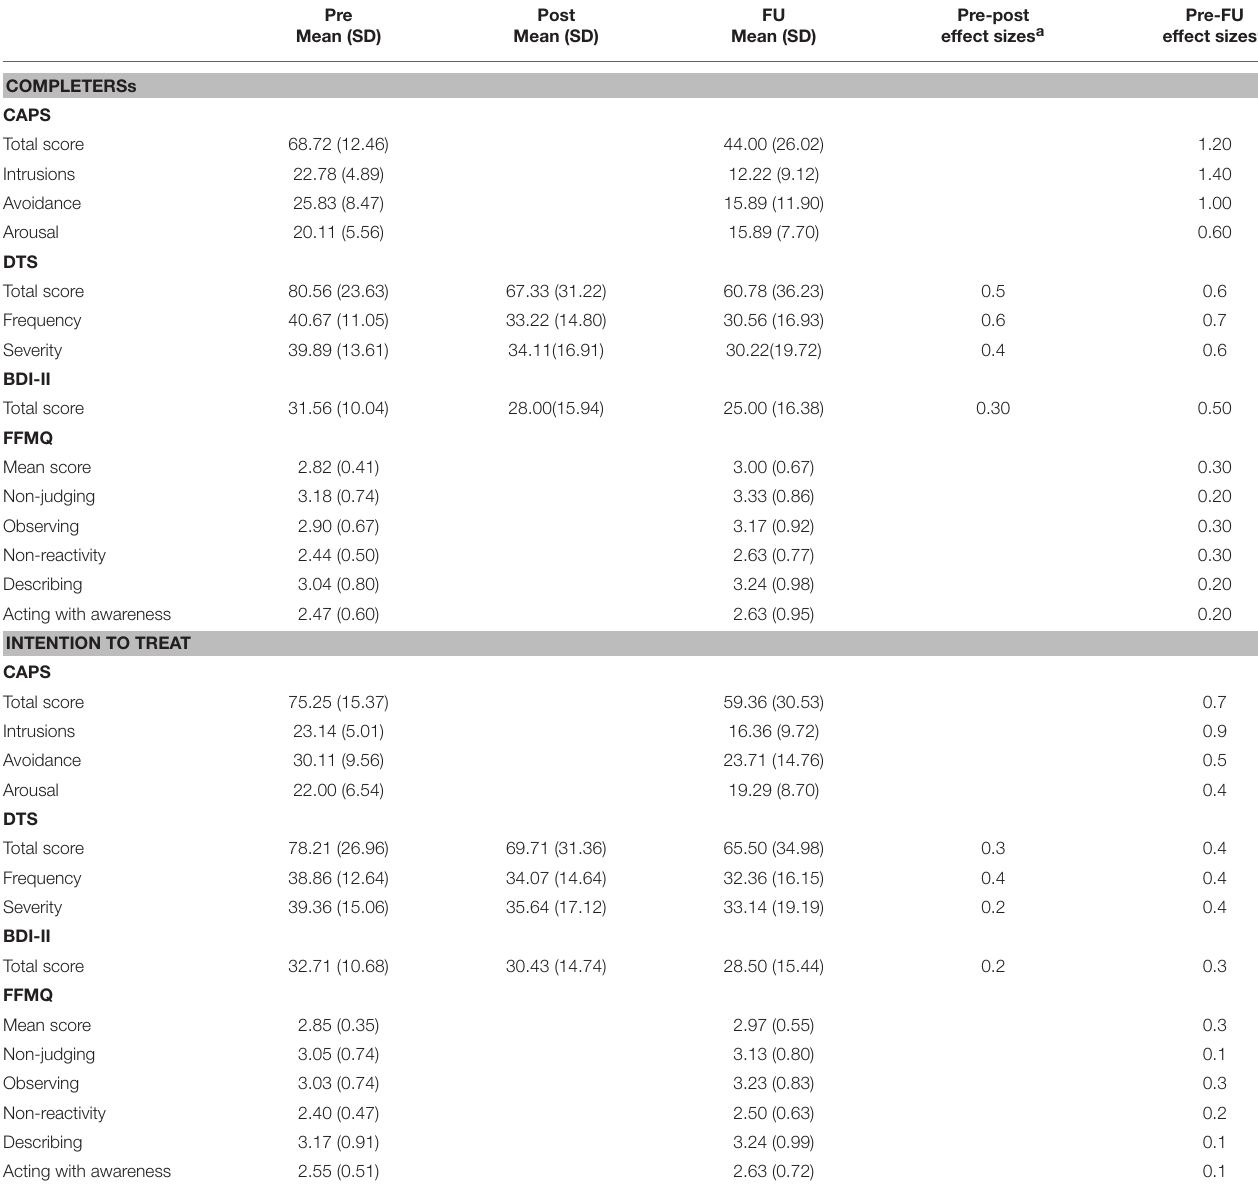
TABLE 1 | Descriptive statistics and effect sizes for completers ( n = 9) and intention to treat ( n =